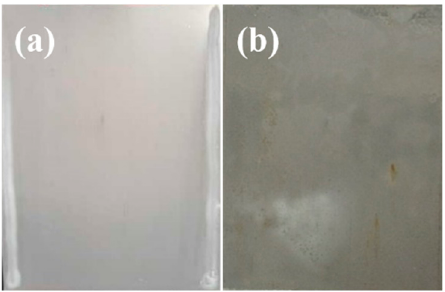
Figure 12. The morphology of sample prepared by Method H: ( a ) new sample and ( b ) after NSS for 72 h.